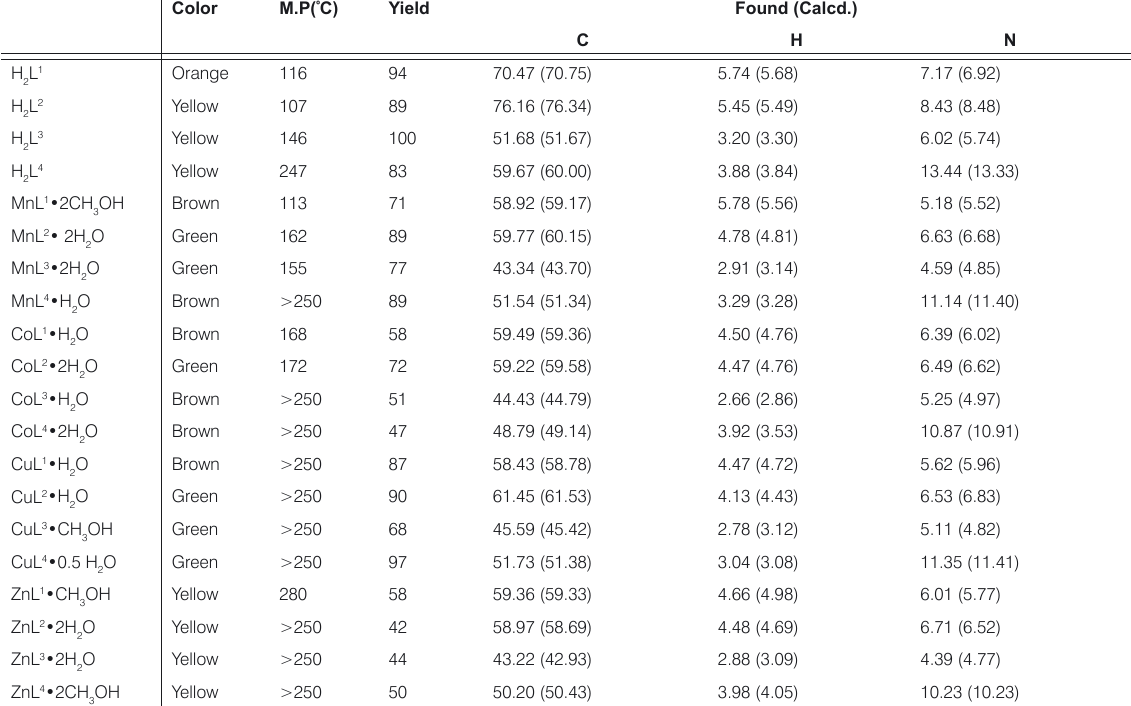
Table 1. Characteristic and analytical data of Schiff bases and their